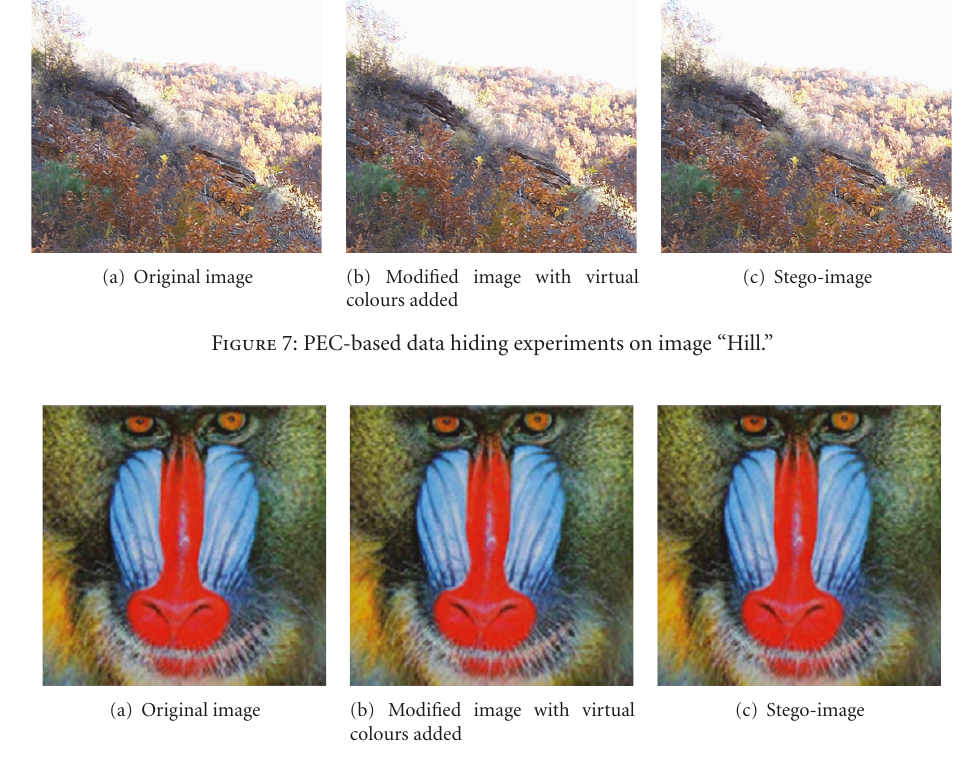
Figure 8: PECPEC-based data hiding experiments on image “Mandrill.”